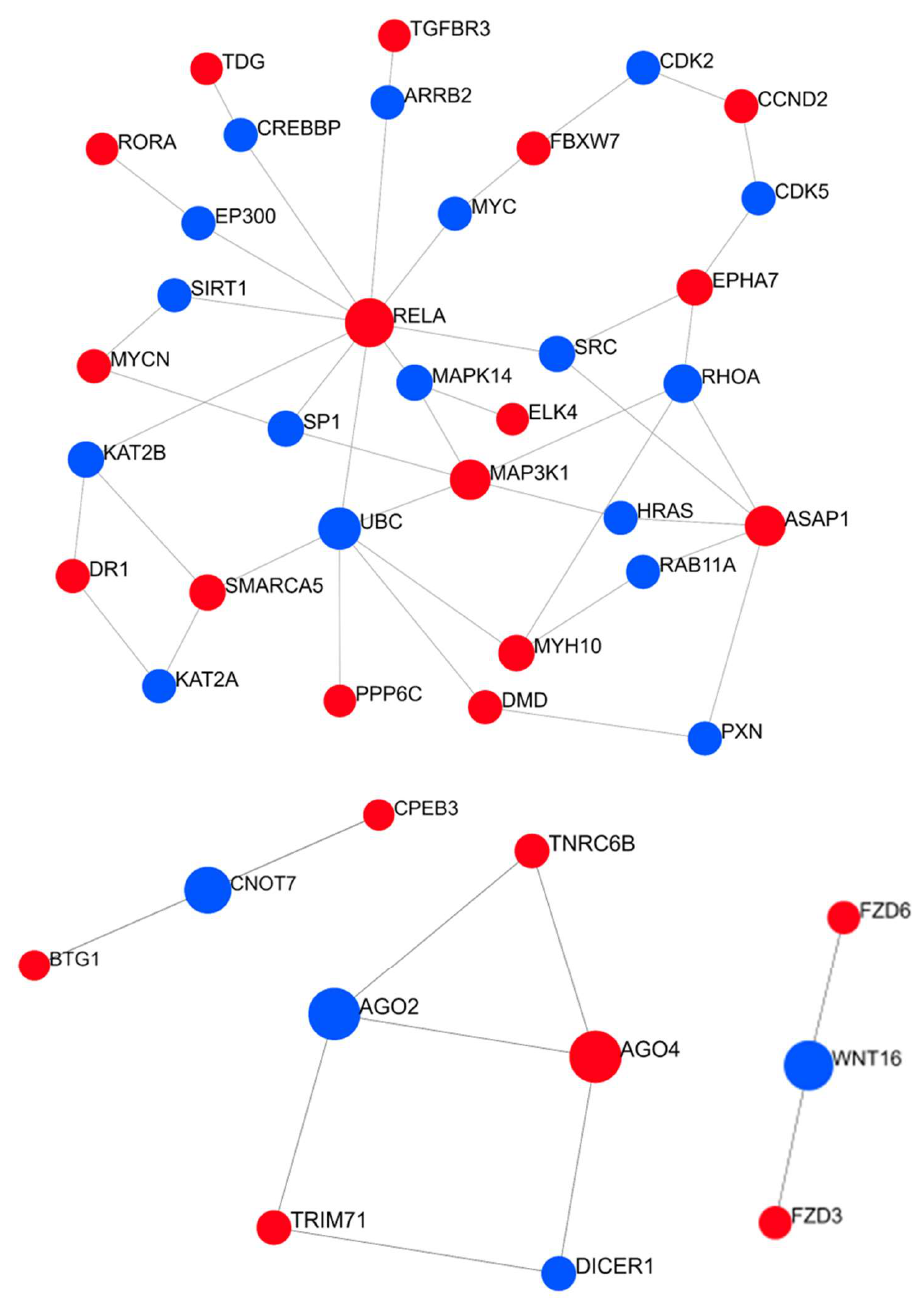
Figure 7. The pathways of protein–protein interactions among the targets of miRNAs dysregulated in the serum of RCD2 patients. The network was generated using NetworkAnalyst 3.0. The target genes representing our input are shown in red, while the remaining genes present in the database are shown in